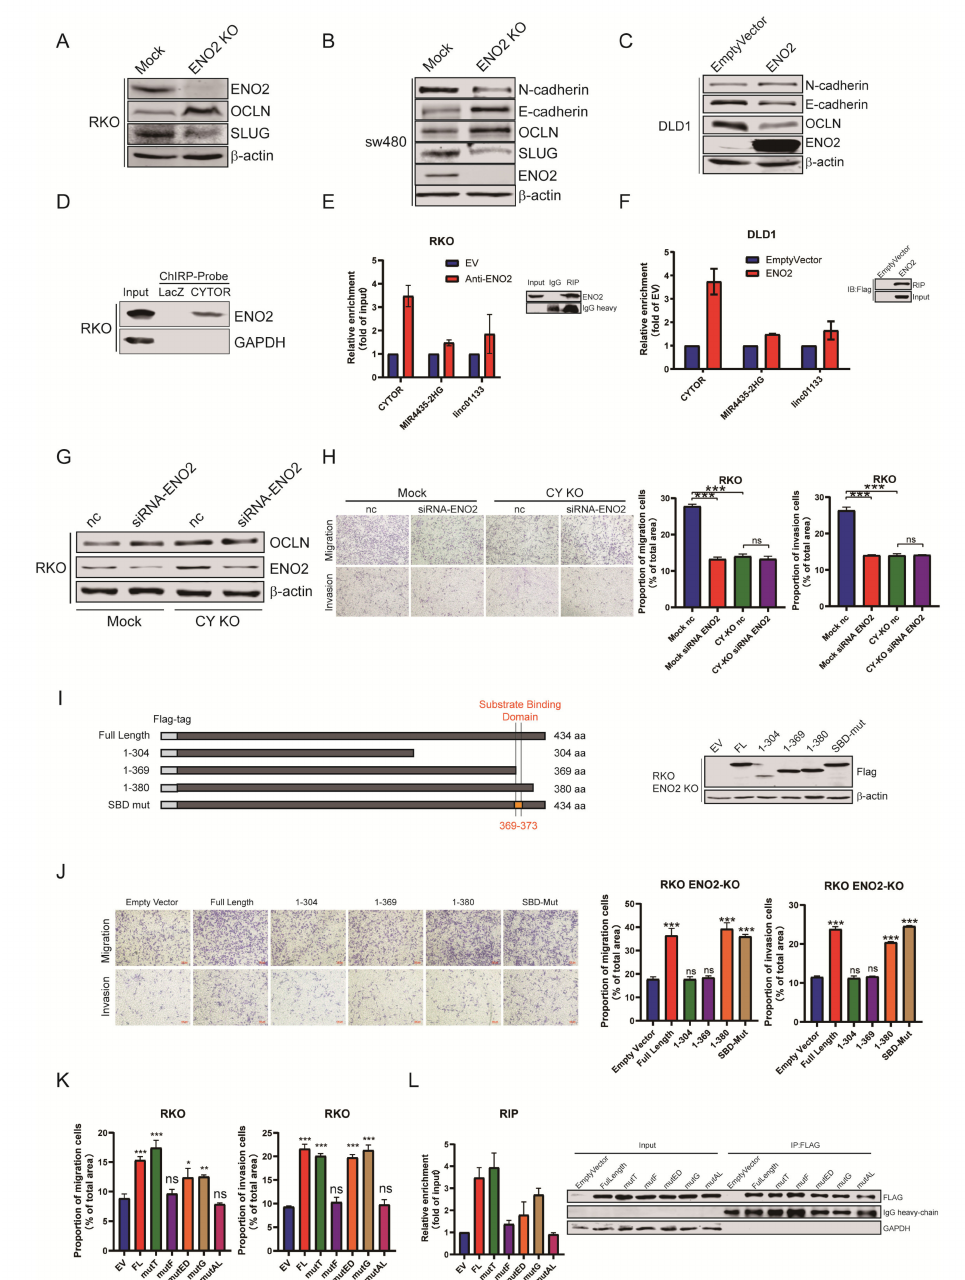
Figure 4. ENO2 induced EMT through a lncRNA CYTOR-dependent pathway. ( A – C ): ENO2 induced the expression of mesenchymal genes. Western blotting was used to analyze the expression of EMT-related genes in stable cell lines. ( D ): RNA pull-down assay results showing that ENO2 was a CYTOR-binding protein. ( E , F ): The RIP experiment detected the binding of ENO2 to CYTOR and several EMT-related lncRNAs. ( G ): The OCLN level in RKO cells with ENO2 knockdown and CYTOR KO. ( H ): The migration and invasion of RKO cells with ENO2 knockdown and CYTOR KO. ( I ): Identification of full-length ENO2 and different truncated ENO2 sequences reintroduced into RKO ENO2 KO cells. ( J ): The functions of the ENO2 truncation mutants depicted in ( I ). ( K ): The function of single point mutations to amino acid residues 374–380 of ENO2. ( L ): RIP assay detected the binding of ENO2 single point mutation to CYTOR. Data are shown as the mean ± SD. * p < 0.05, ** p < 0.01, *** p < 0.001. ns: non